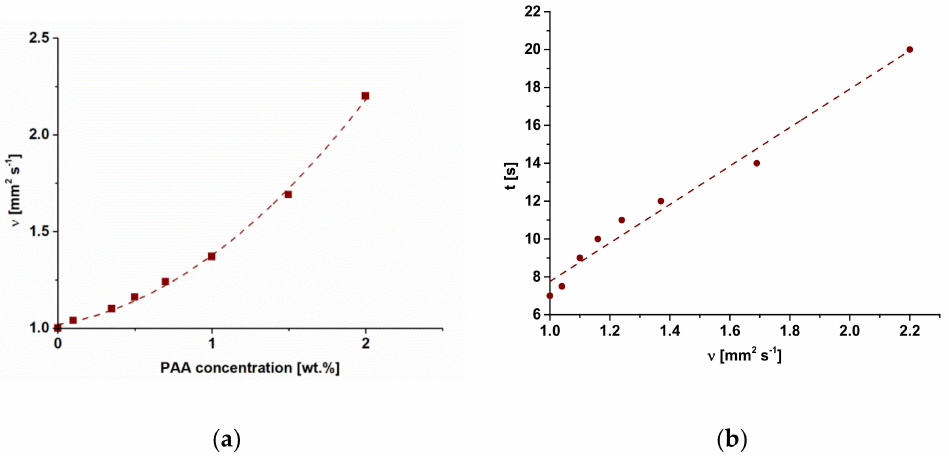
Figure 4. Dependence of kinematic viscosity ( ν ) of PAA aqueous solution on PAA concentration ( a ) and dependence of membrane formation time (t) on kinematic viscosity of PAA aqueous solution ( b ). It was shown that introduction of PAA to the coagulant results in only a little increase in membrane formation time since the PAA molecular weight is not very high (Figure